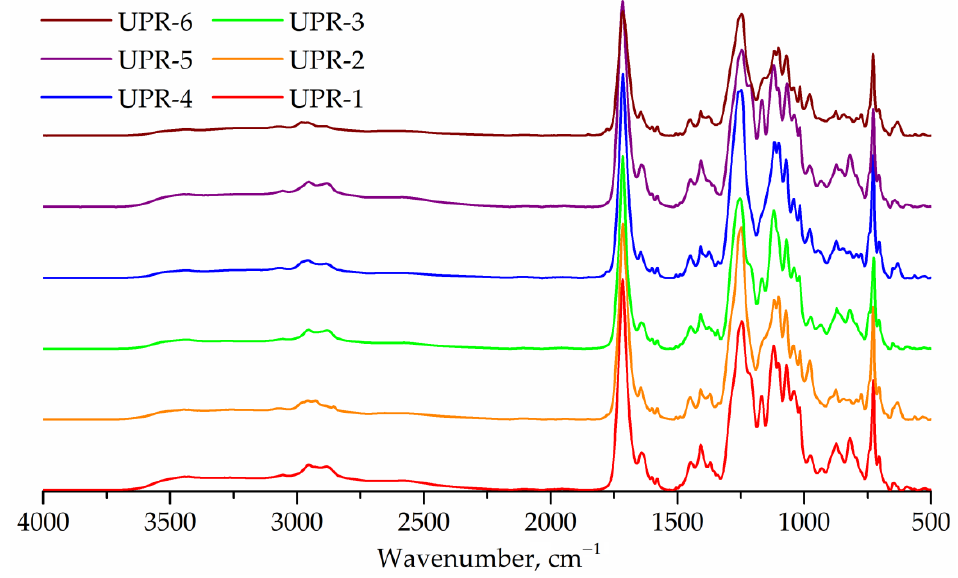
Figure 10. FTIR spectra of UPR-1, UPR-2, UPR-3, UPR-4, UPR-5, and UPR-6 samples. The GPC curves of the obtained UPRs are shown in Figure 11. In addition to the main peaks of oligomers, all curves contain weak peaks in the range 147–167 g/mol, corresponding to maleic acid ethylene, diethylene or 1,2-propylene glycol monoester, respectively. Peak molecular weights for UPR-1, UPR-2, UPR-3, UPR-4, UPR-5, and UPR-6 samples are 780, 753, 694, 794, 590, and 620, respectively.